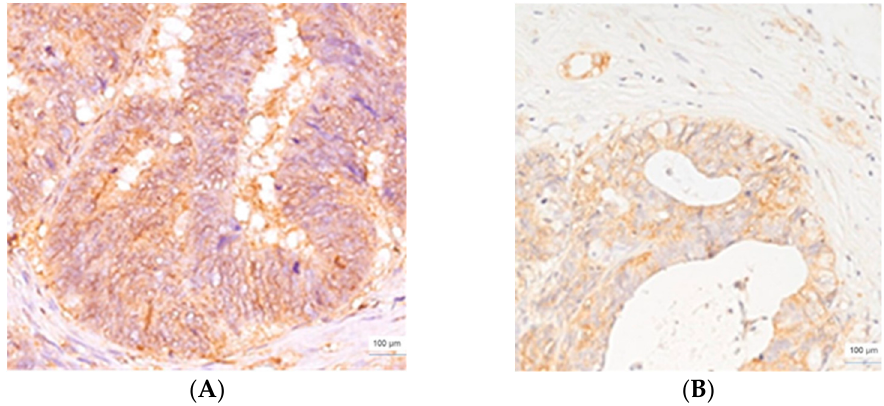
Figure 3. CLIC1 immunoexpression, colorectal adenocarcinoma, score of 2, ×400 magnification ( A ), and LM, desmoplastic HGP, score of 2, ×200 magnification ( B ). Evaluation of the colorectal and gastric adenocarcinomas revealed a value of 3 for the CLIC1 score (seven colorectal cases and one gastric case) and a value of 2 (five colorectal cases and two gastric cases). The following CLIC1 scores characterized their corresponding LMs with a p-HGP: 3 (five colorectal cases and two gastric cases) and 2 (seven colorectal cases and one gastric case). Gastric LMs with a p-HGP quantified with a score of 3 presented the highest intensity of CLIC1 expression at the periphery of the metastatic area (Figure 4). The nuclear expression pattern was noticed mainly at this level. CLIC1 ‐ positive sinusoids and cells with a dendritic morphology were noticed in the vi ‐ cinity of the metastatic area. For the LMs with a p ‐ HGP with a colorectal origin, the nu ‐ clear pattern and highest intensity of CLIC1 localization were maintained. A particular aspect was the presence of CLIC1 ‐ positive cells with a star ‐ shape morphology, in the subcapsular area. ( A ) ( B ) Figure 4. CLIC1 immunoexpression, gastric adenocarcinoma, score of 2, ×400 magnification ( A ), and corresponding LM, pushing HGP, score of 3, ×200 magnification ( B ). CLIC1 expression inten ‐ sity in the cytoplasm (purple arrow ) increased in the nucleus (blue arrow ) of the cell. Thirteen cases—six of colorectal origin and seven of pancreatic origin—developed LM with an r ‐ HGP. A CLIC1 score of 3 was found in 50% of the colorectal adenocarci ‐ nomas, with a score of 2 being found for the other half. The distribution of the CLIC1 scores in LMs with an r ‐ HGP of colorectal origin was: 3 (three cases), 2 (two cases), and 1 (one case). The CLIC1 scores of pancreatic adenocarcinomas were heterogeneous: 3 (three cases ‐ Figure 5A), 2 (two cases), 1 (one case), and 0 (one case). Compared to the